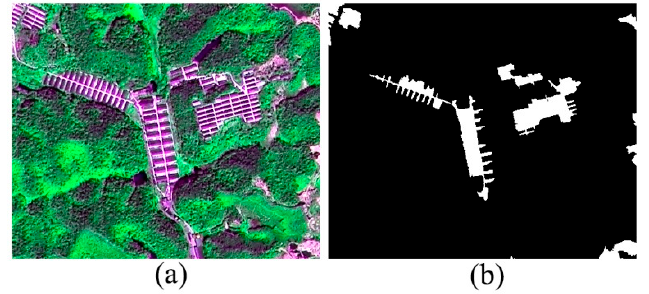
Figure 10. Partial impervious surface mixed with REO mined area. (a) The source image; (b) experimental result.